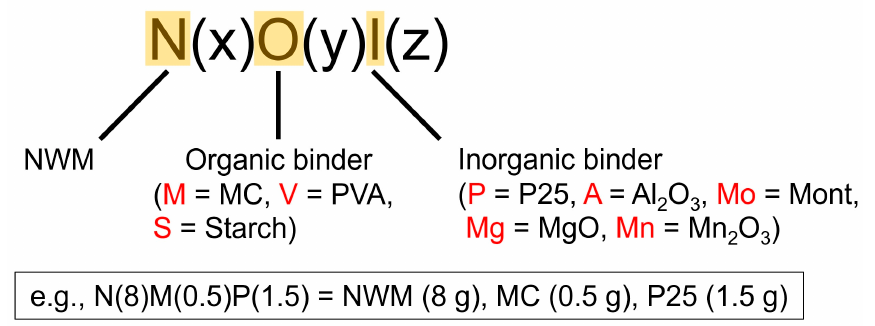
Scheme 1. Nomenclature of NWM pellets. Table 1. Physical properties of the catalyst pellets a . Table 1. Physical properties of the catalyst pellets a . Catalyst Fracture Strength (MPa) BET Surface Area (m 2 /g) NWM